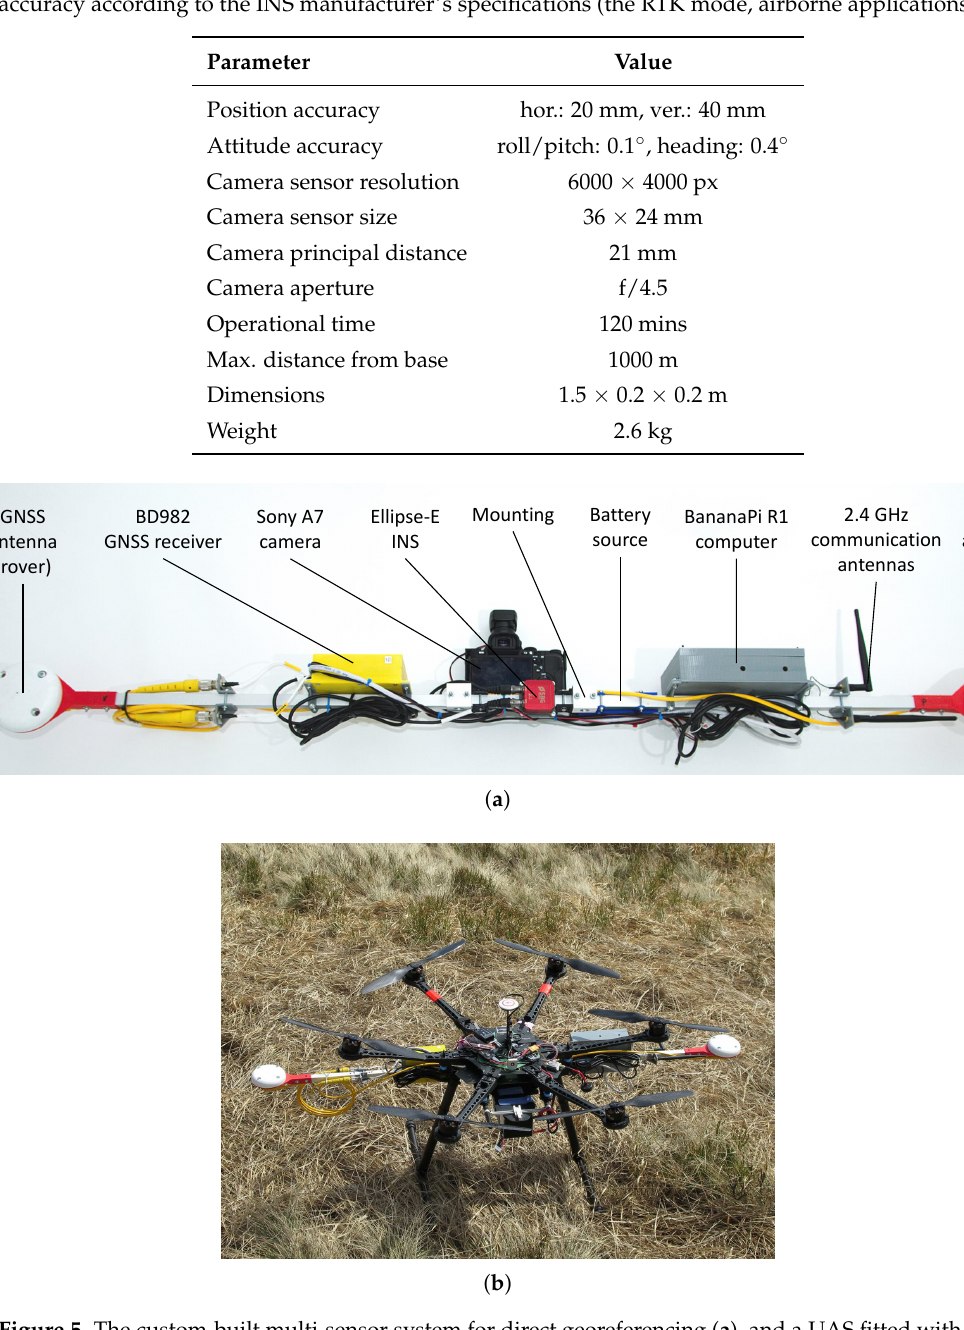
Figure 5. The custom-built multi-sensor system for direct georeferencing ( a ), and a UAS fitted with the system during a previous mapping mission ( b